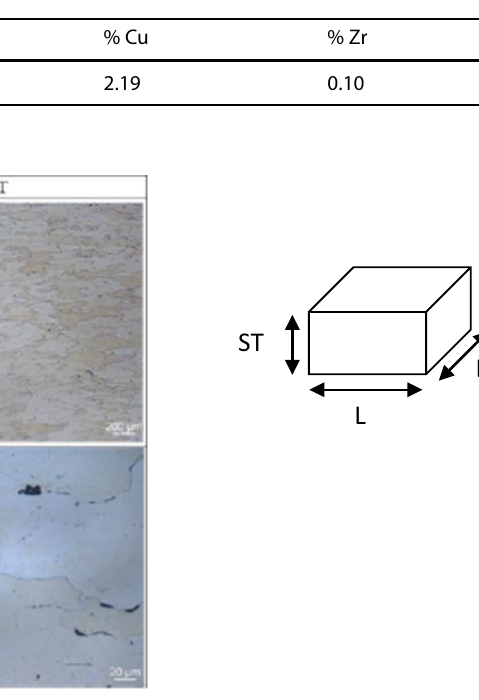
Fig. 1 LOM observations of the 7050 AA, T76 temper for the L-ST and LT-ST